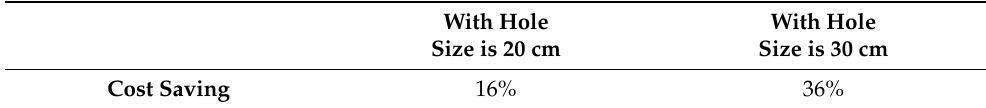
With Hole With Hole Size is 20 cm Size is 20 cm